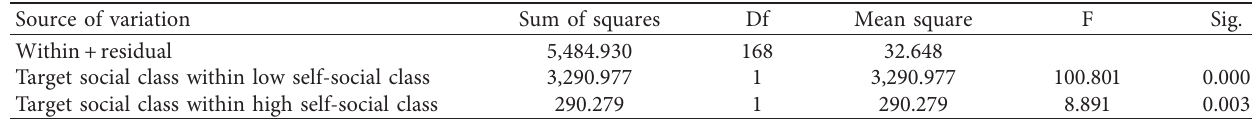
Figure 2: The effect of social class on the number of points in the dictator game from China college students. Table 3: The ANOVA results of the test of simple